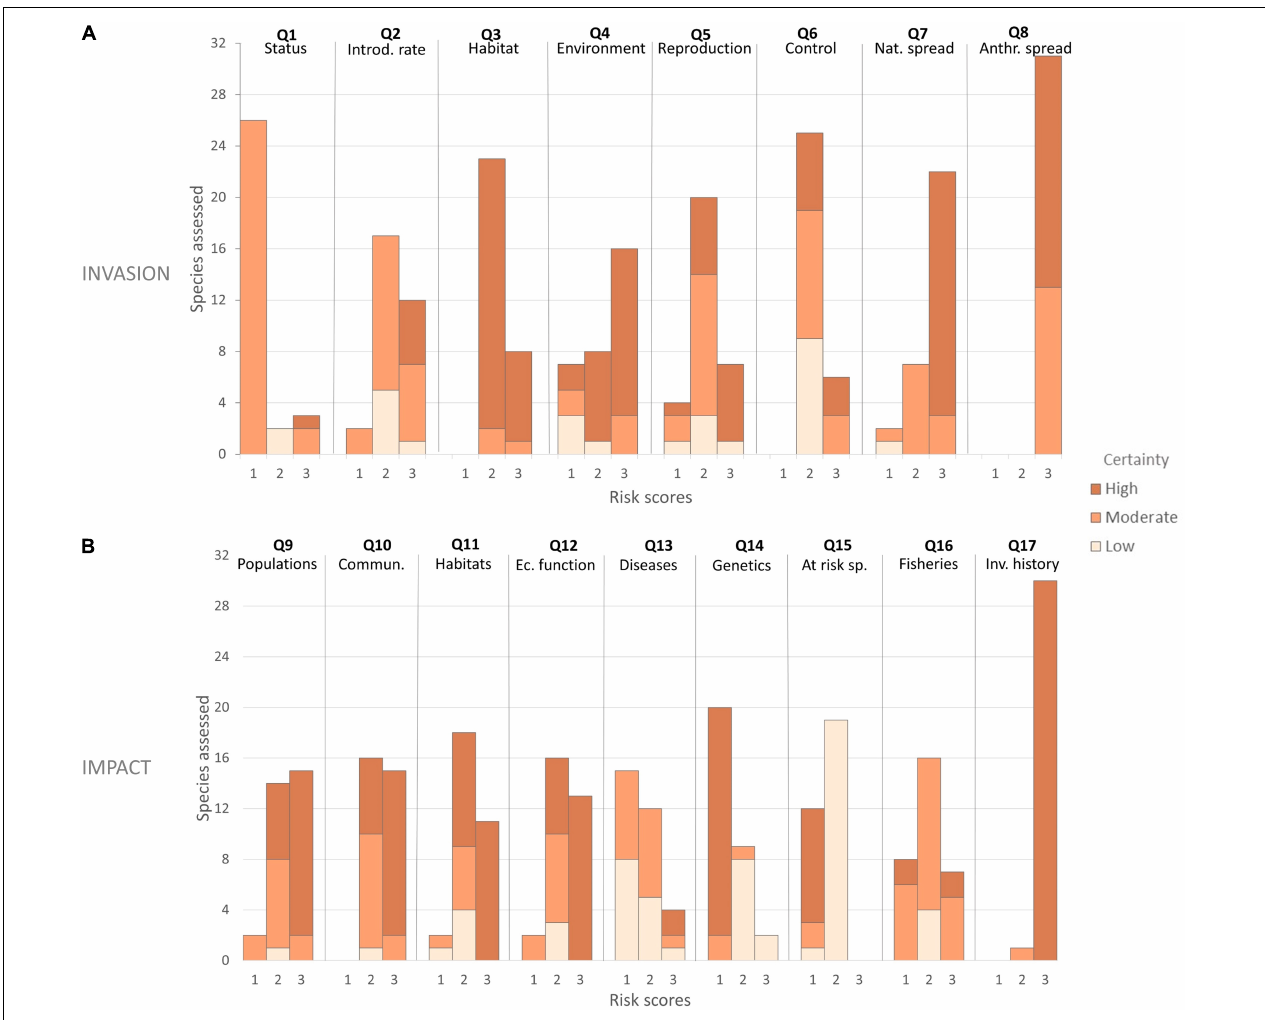
FIGURE 6 | Frequency of risk scores used in the set of 31 species assessed using CMIST in the RA area, together with their degree of certainty. Risk scores from 1 (low) to 3 (high) describe the relative risk of AIS in the RA area (e.g., for Question 1, three species received a risk rating of 3 for high (x-axis), the certainty of these rankings was high for one species (dark bar shade) and moderate for two (medium bar shade). Panel (A) shows the scores of Questions 1–8 related to Invasion: (1) present status, (2) rate of introduction, (3) survival-habitat, (4) survival-environment, (5) establishment-reproduction, (6) establishment-control, (7) spread-natural, and (8) spread-anthropogenic; Panel (B) shows Questions 9–17 related to Impact: (9) on populations, (10) on communities, (11) on habitats, (12) ecosystem function, (13) parasite and diseases, (14) genetics, (15) at risk species, (16) aquaculture/fisheries, (17) past invasion history). See Supplementary Table 1 for the full text of each question; see also Drolet et al. (2016). Certainty values score from low (mostly uncertain) to high (very